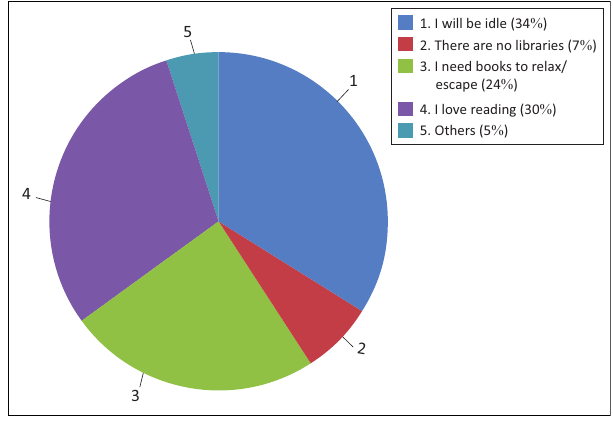
FIGURE 6: Responses to the question, ‘How will you feel if the reading project is